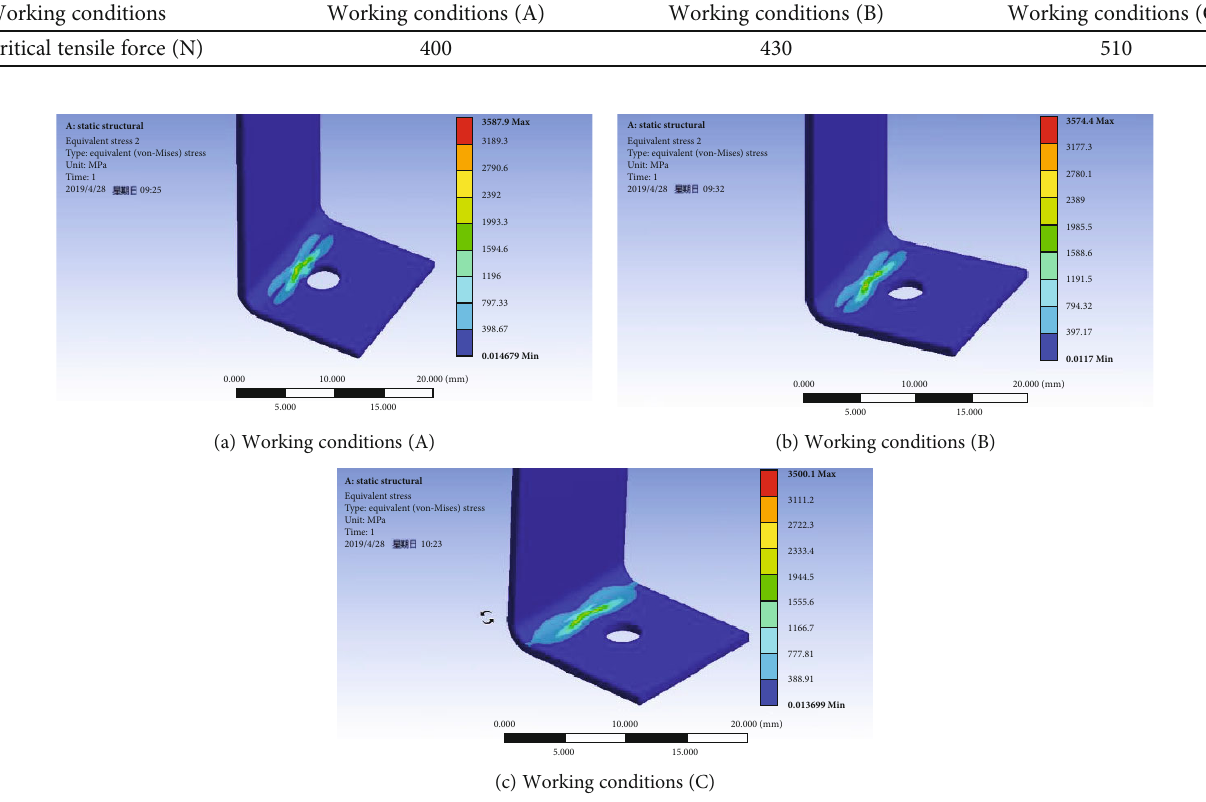
Figure 24: The stress cloud map corresponding to the change of the diameter of the riveting joint of the kevlar ribbon. A: static structural Equivalent elastic strain 2 Type: equivalent elastic strain